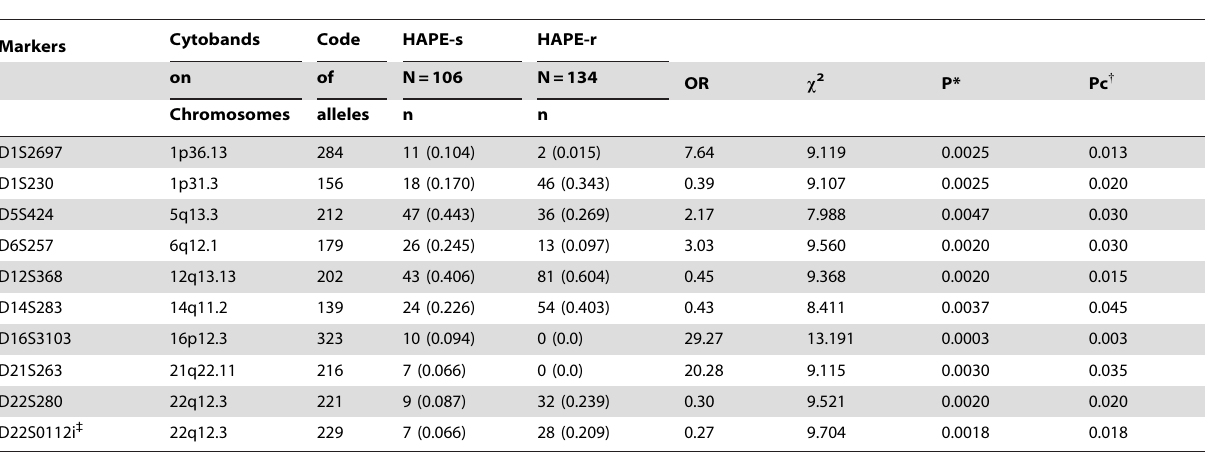
Table 1. The microsatellite markers with statistically significant associations with HAPE.